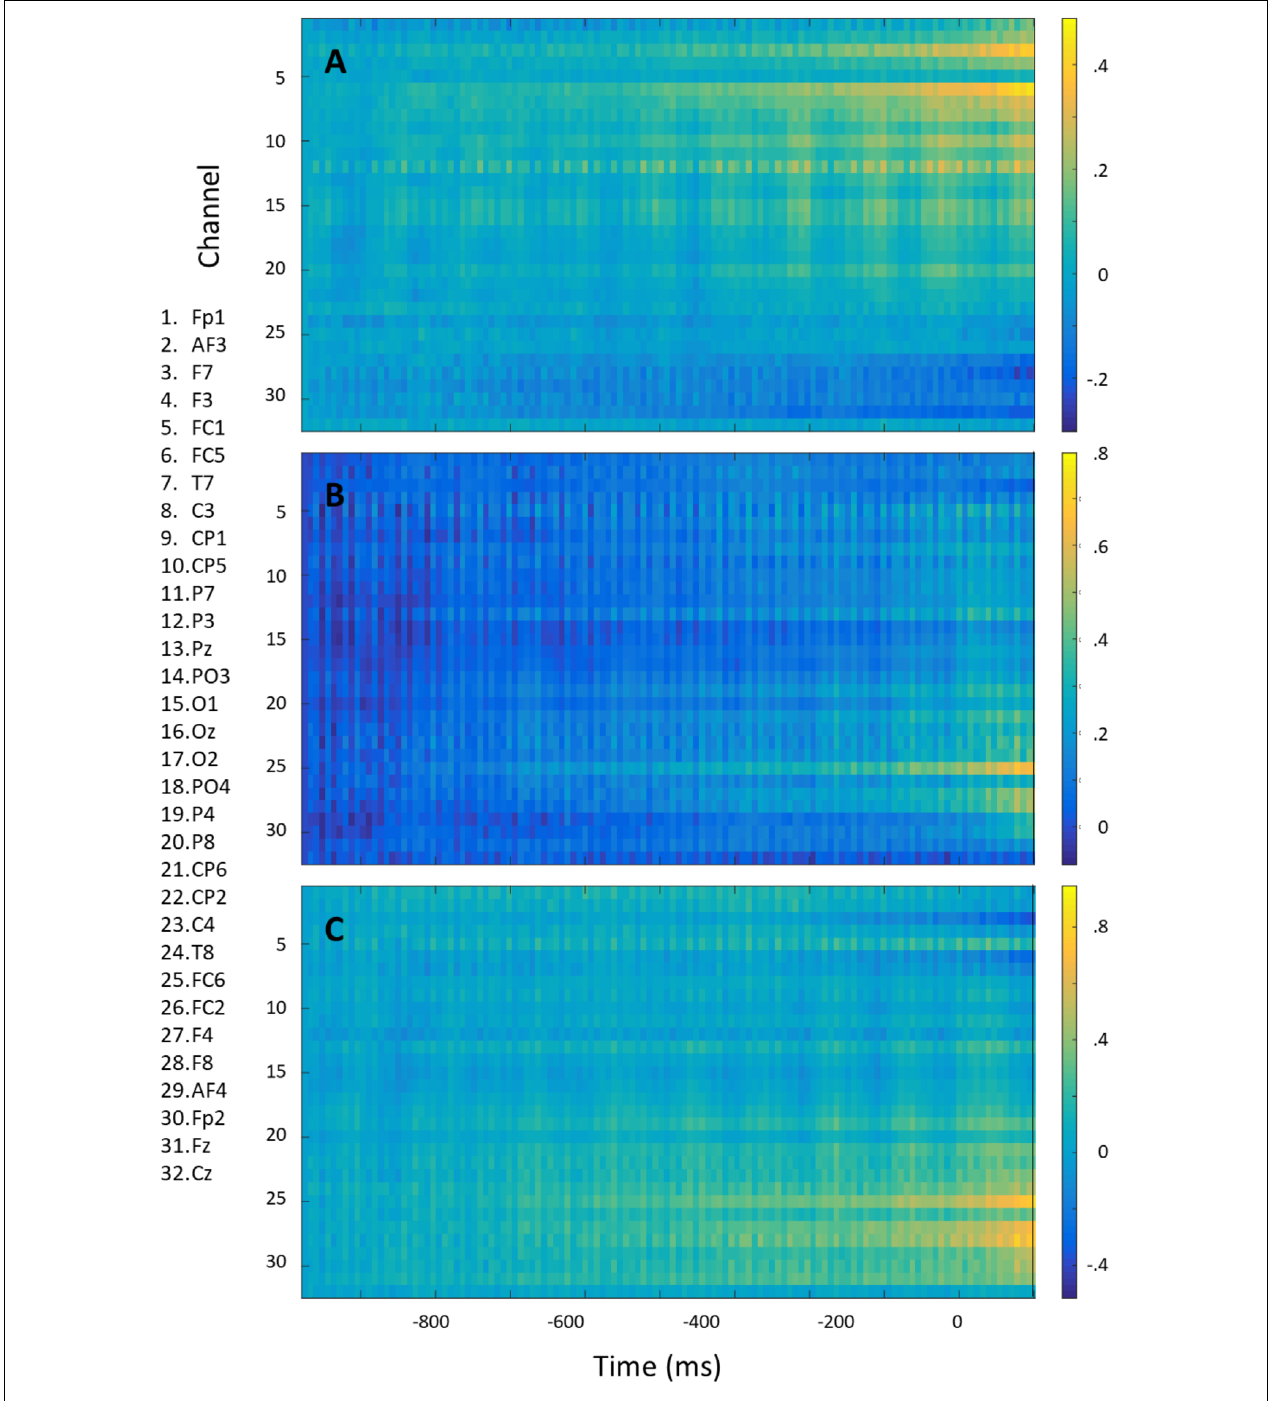
FIGURE 8 | Mean voltage over the 1000 ms preceding right (A) and left (B) rotation onset and their difference (left minus right) (C) for each electrode. Epochs were baselined on –1000 ms.